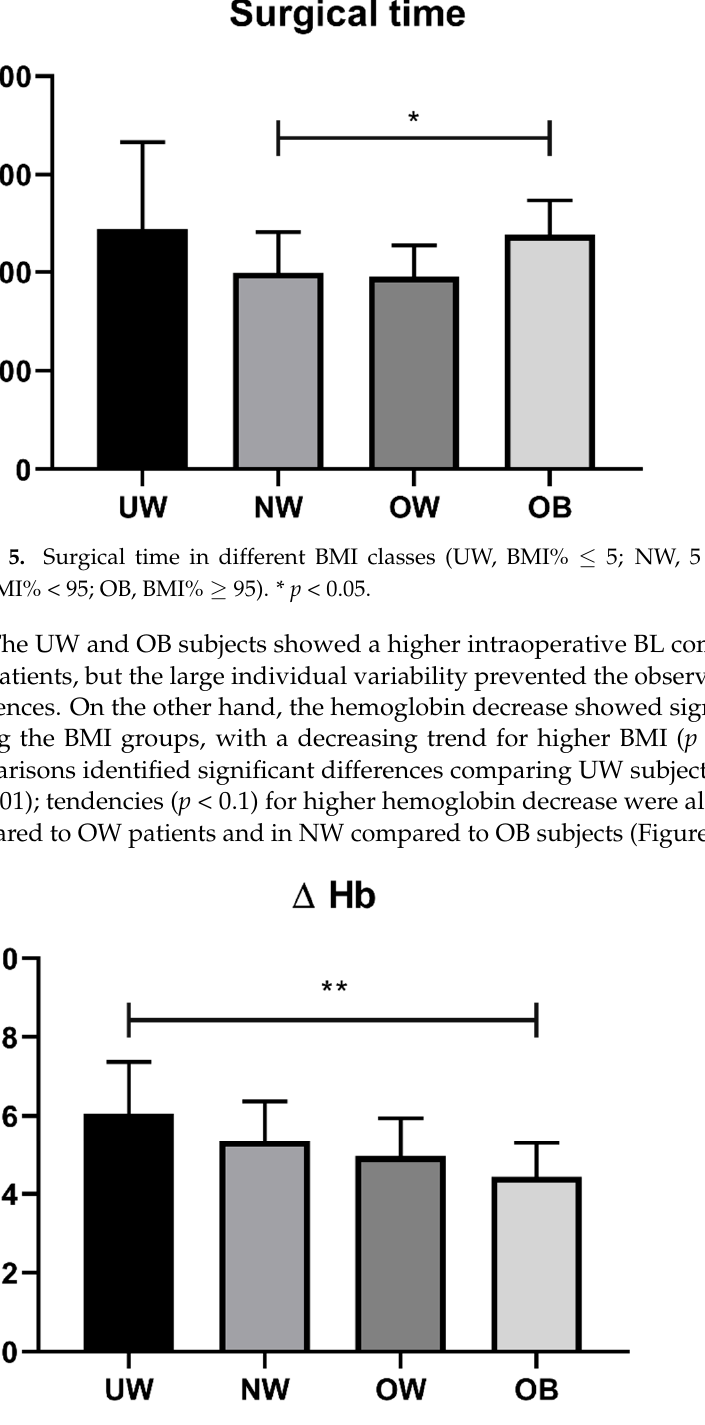
Figure 4. BMI classes (UW, BMI% ≤ 5; NW, 5 < BMI% ≤ 84; OW, 84 < BMI% < 95; OB, BMI% ≥ 95) per Lenke classification.